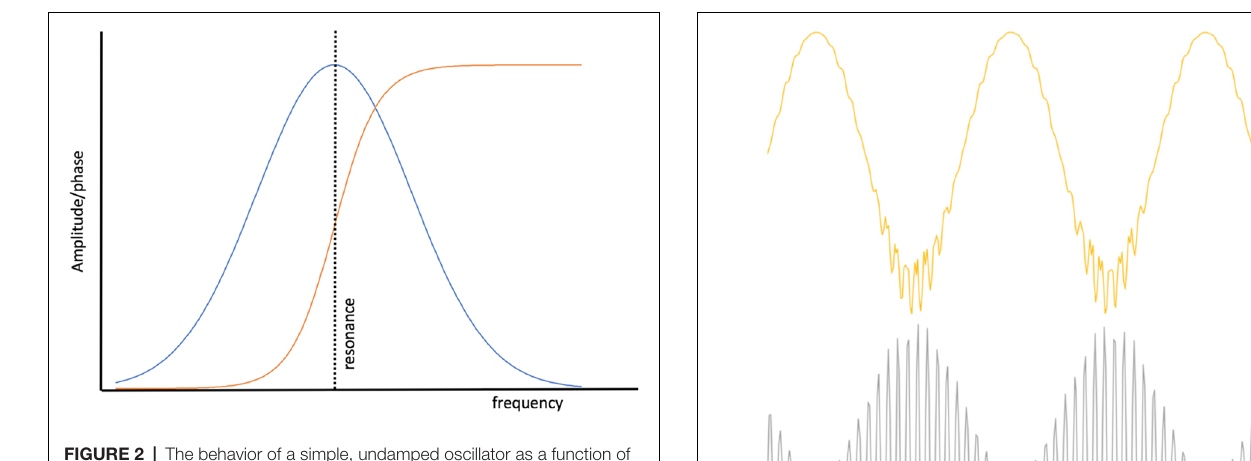
the same thing, in the neuroscience, electrical engineering, and